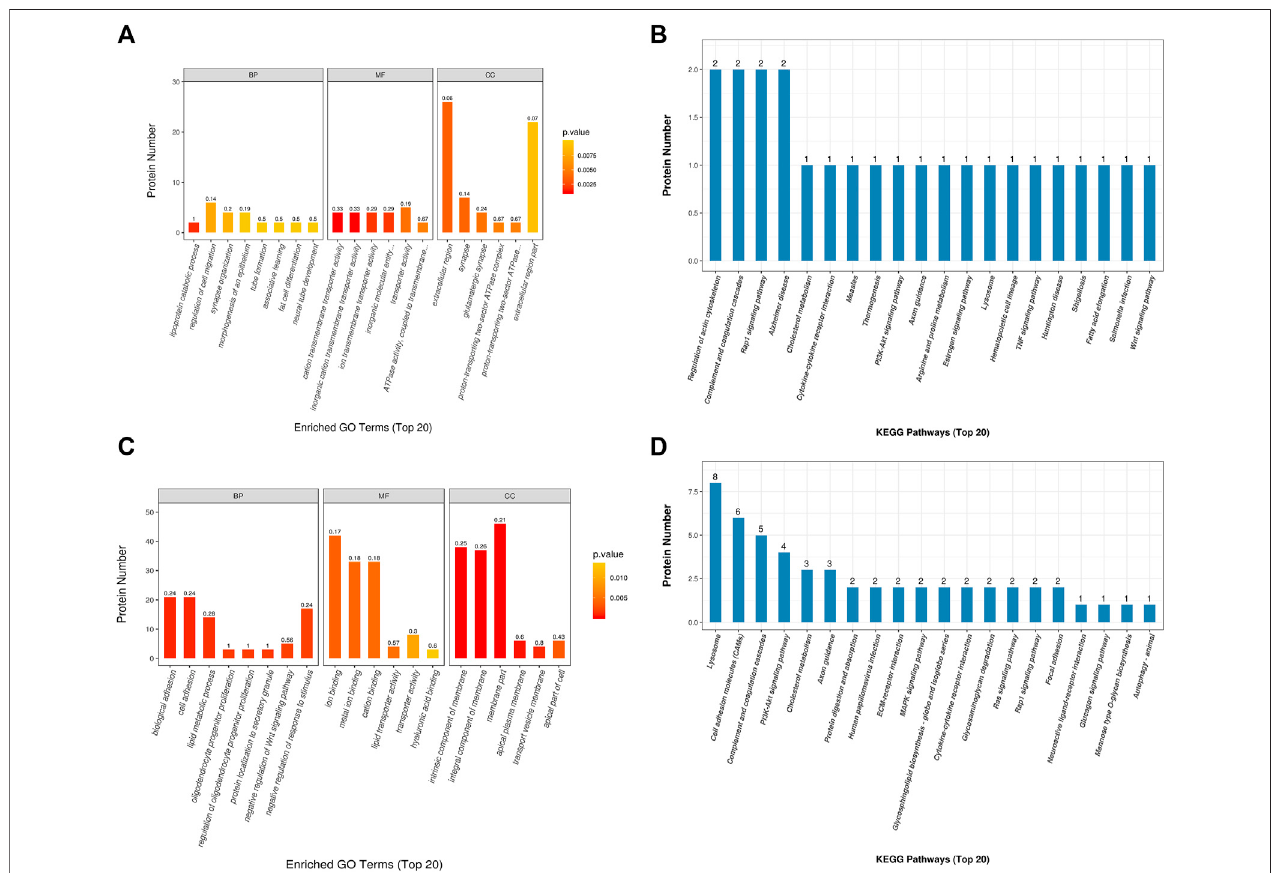
FIGURE 4 | Gene Ontology and Kyoto Encyclopedia of Genes and Genomes analyses. (A , B) SO vs . FA. (C , D) SO vs .